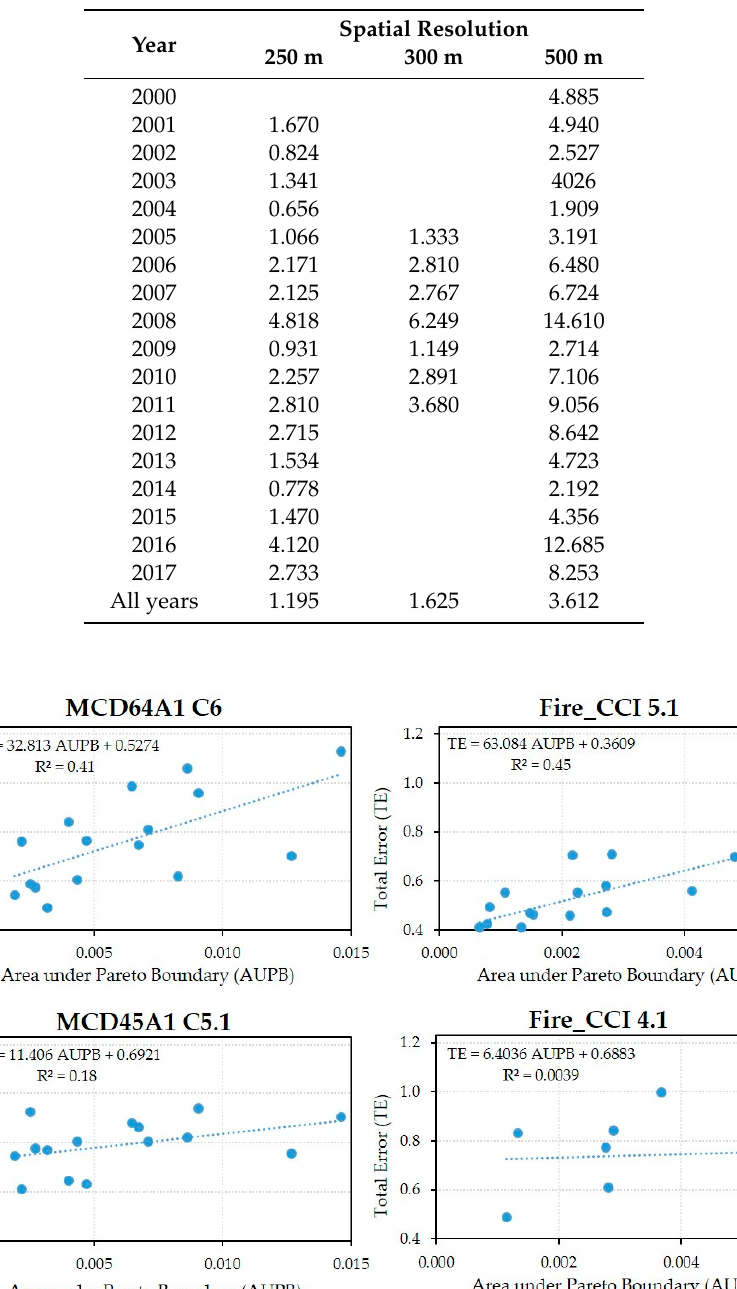
Table 5. Areas ( × 10 − 3 ) enclosed by the annual Pareto Boundaries (AUPB) at di ff erent resolutions and the weighted average value for all years.